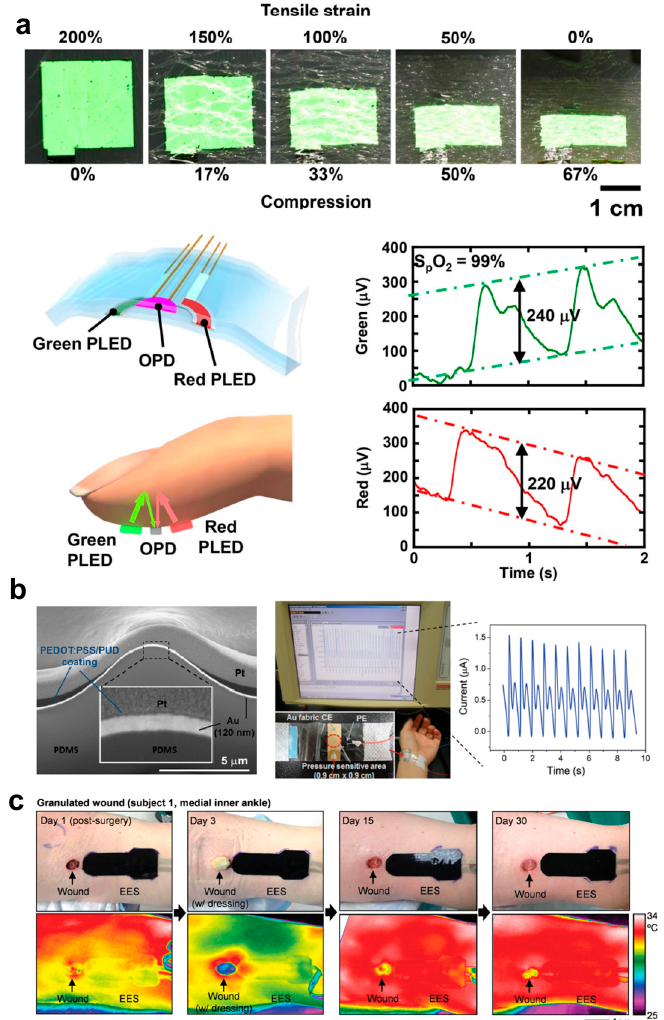
Figure 10. Skin sensors used for other sensing applications: ( a ) a skin sensor that can measure oxygen concentration of blood (Reprinted with permission from Ref [177] Copyright 2016 The Authors); ( b ) a stretchable resistive pressure sensor (Reprinted with permission from Ref [182] Copyright 2014 John Wiley and Sons); and ( c ) an epidermal electronics system that can monitor cutaneous wound healing (Reprinted with permission from Ref. [180] Copyright 2014 John Wiley and Sons).